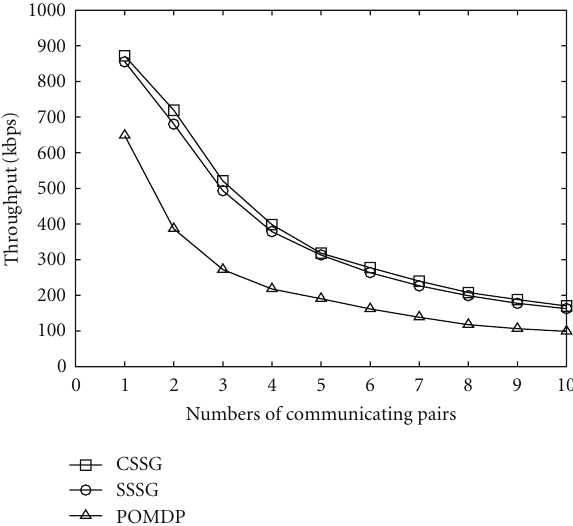
Figure 9: Average Throughput; Channel 1: β = 0.8; Channel 2: β = 1.0; Channel 3: β =